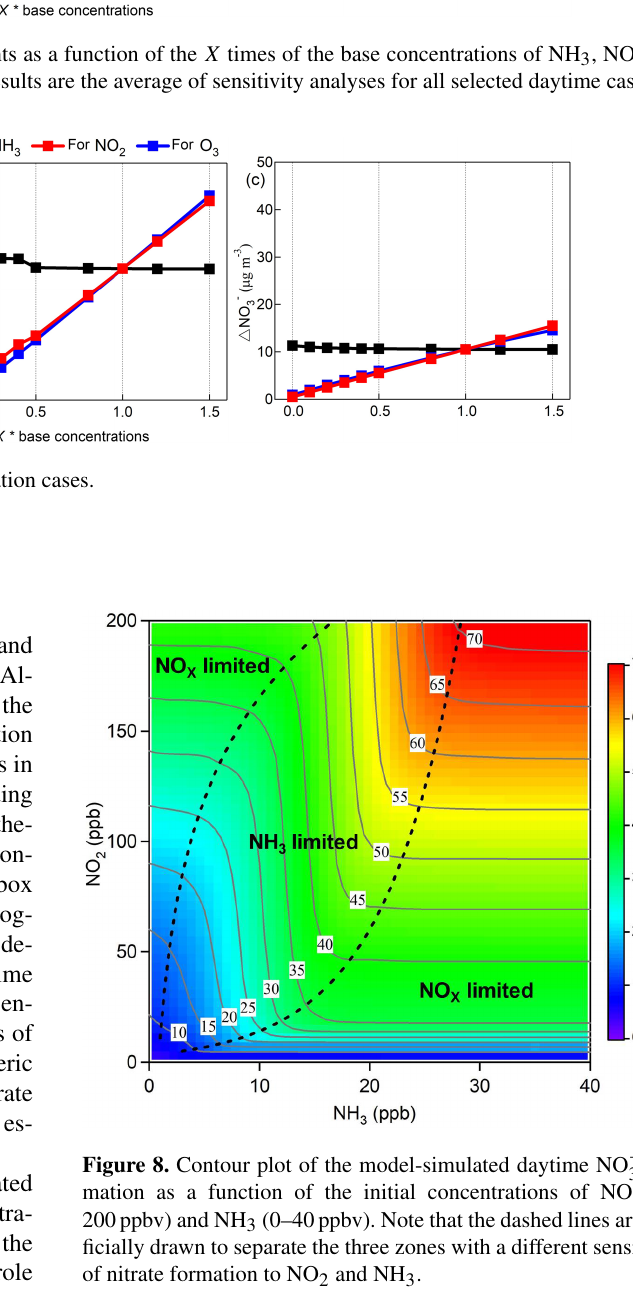
Figure 6. Model-simulated daytime average NO −